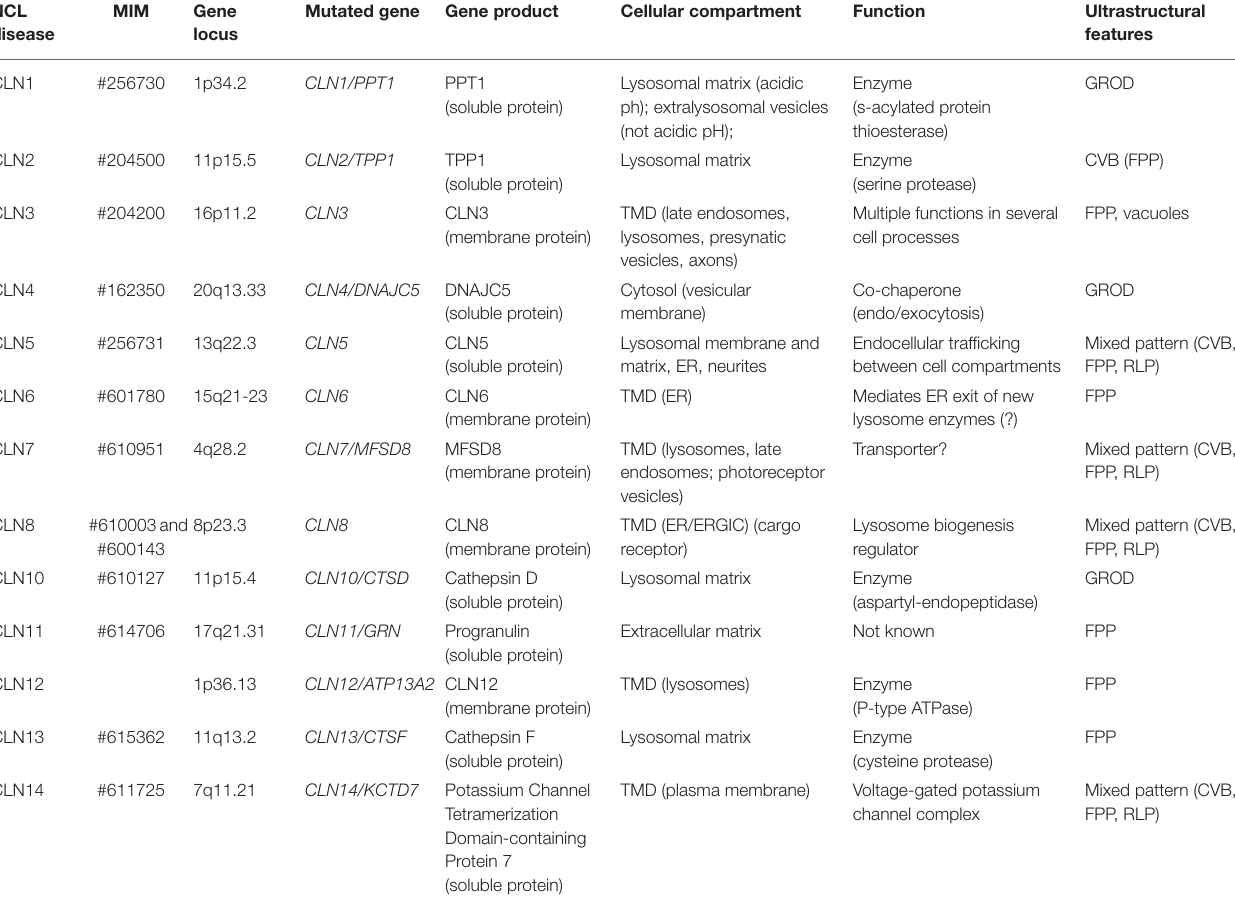
TABLE 3 | NCL: genetic, biochemical and ultrastructural features of each form. NCL Gene Mutated gene Gene product Cellular compartment Function Ultrastructural disease locus